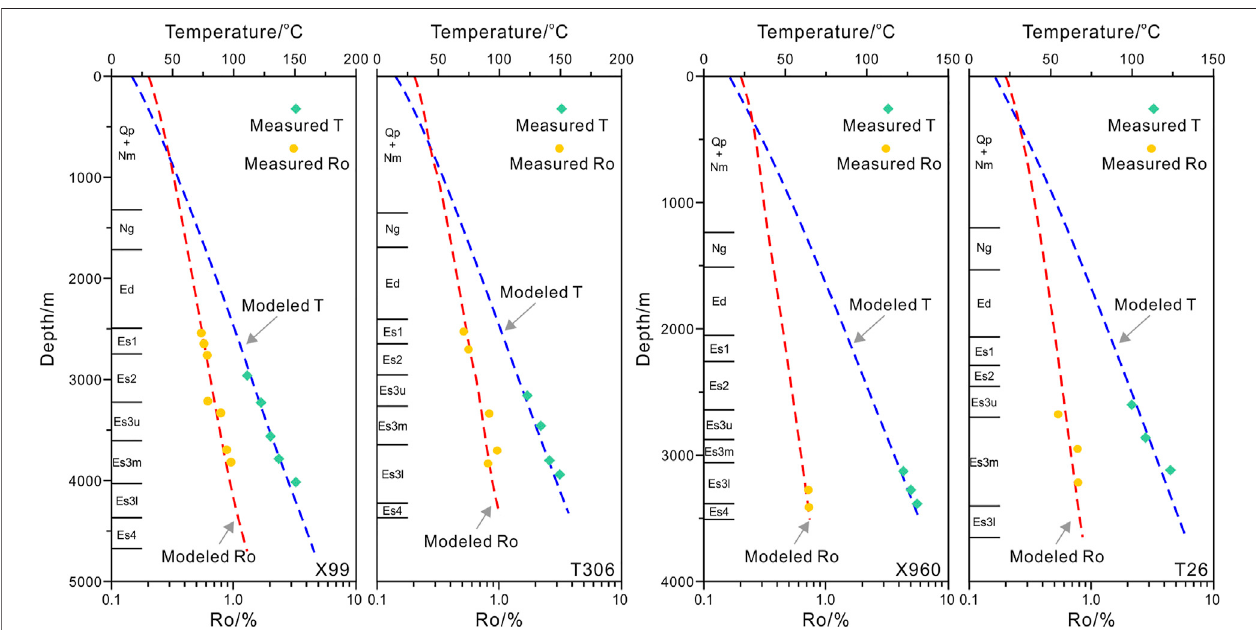
FIGURE 7 | Calibration of thermal and maturity modeling for four wells in the Linnan Sag showing good correlations between the measured and calculated values. The well locations are shown in Figure 1 .